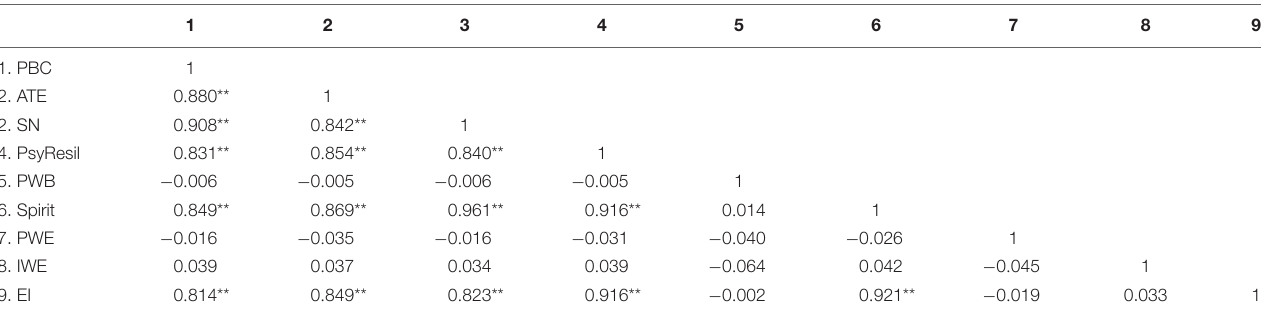
TABLE 3 | Pearson correlation